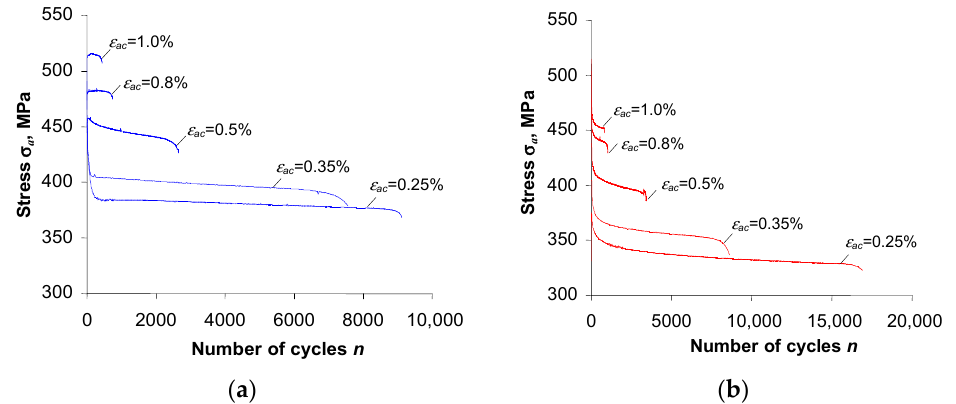
Figure 4. Hysteresis loop and its basic parameters.